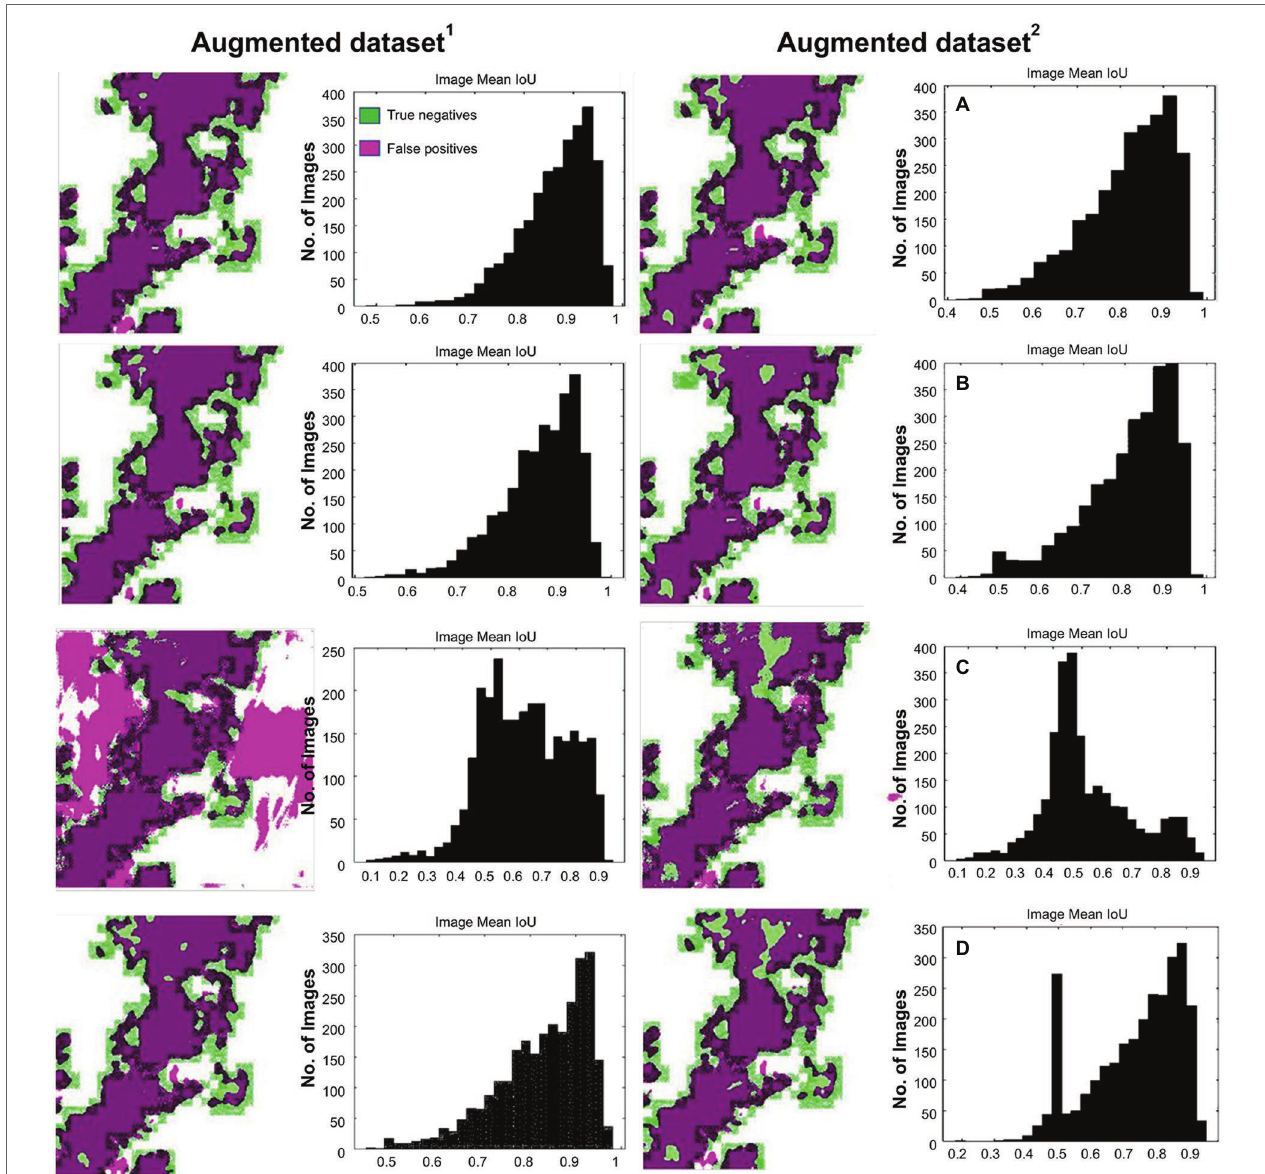
FIGURE 13 | Test result vs. expected ground-truth (labeled) with intersection over union (IoU) histogram. (A) Deeplabv3plus (ResNet50). (B) Deeplabv3plus (MobileNetv2). ( C) U-Net. (D)